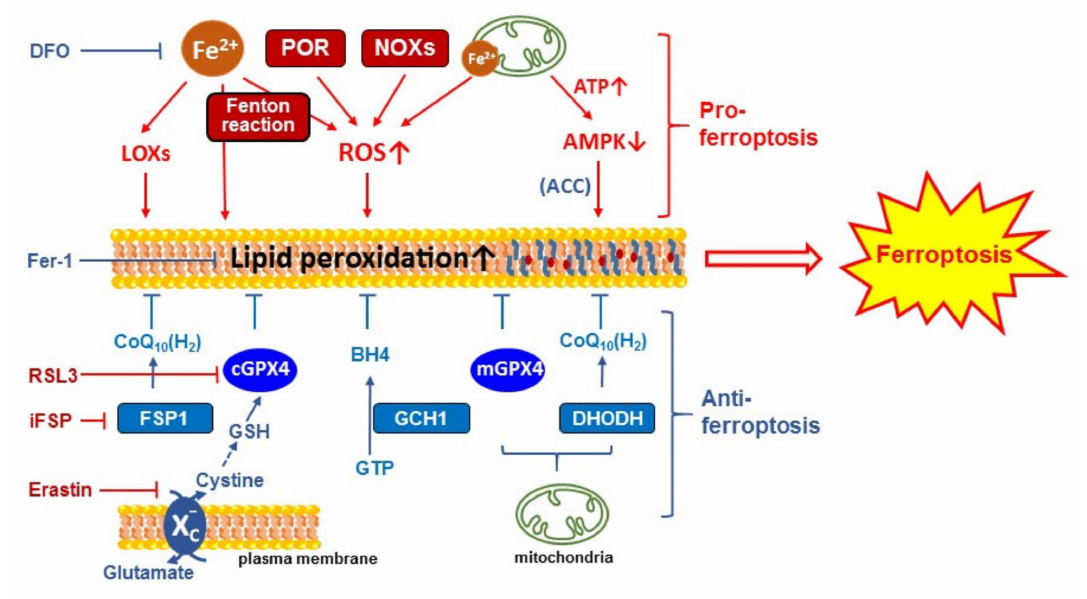
Figure 2. Regulatory mechanism of ferroptosis. Ferroptosis is induced by iron-dependent lipid peroxidation in plasma or mitochondrial membrane. Pro-ferroptosis (red) and anti-ferroptosis (blue) pathways are shown. Well-used ferroptosis inducers (e.g., RSL3, iFSP, and Erastin) and inhibitors (e.g., DFO and Fer-1) and their targets are indicated. The accumulation of cytosolic and mitochondrial iron, increased ROS, and lipid peroxidation promote ferroptotic cell death. DFO: deferoxamine; POR: P450 oxidoreductase; NOX: NADPH oxidases; LOX: lipoxygenase; ROS: reactive oxygen species; AMPK: AMP-activated protein kinase; ACC: acetyl-CoA carboxylase; Fer-1: ferrostatin-1; CoQ10: coenzyme Q10; RSL3: RAS-selective lethal 3; GPX4: glutathione peroxidase 4; FSP1: ferroptosis suppressor protein 1; DHODH: dihydroorotate dehydrogenase; GSH: glutathione; GCH1: GTP cyclohydrolase 1; BH4: